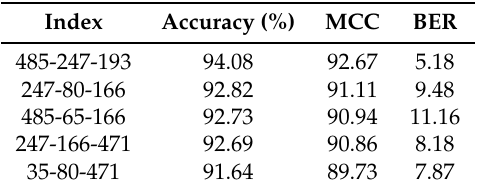
Table 12. Highest accuracy results of RBM using the amino acid property three-index combinations from Table